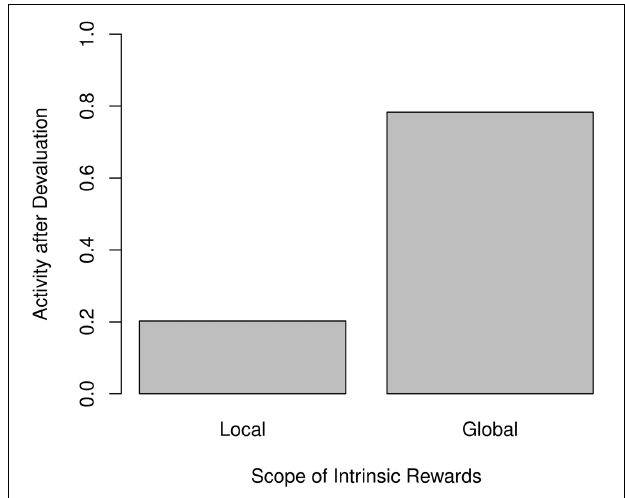
FIGURE 8 | Relative amounts of non-null action after devaluation for local (left) and global (right) intrinsic rewards. Activities are normalized to the pre-devaluation level.